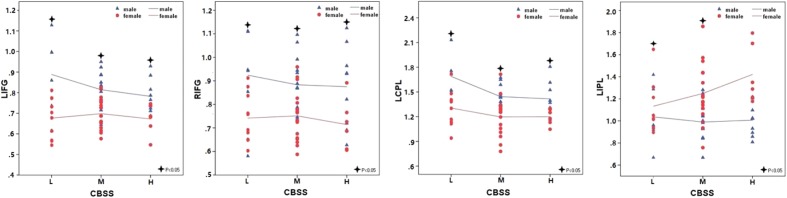
The comparisons in the high, low, and middle shy subgroup showed significant ALFF differences in LIFG, RIFG and LCPL between males and females and low and middle shy subgroup showed significant ALFF difference in LIPL between males and females. LIFG, left inferior frontal gyrus; RIFG, right inferior frontal gyrus; LCPL, left cerebellum posterior lobe; LIPL, left inferior parietal lobule; L, low; M, middle; H, high.